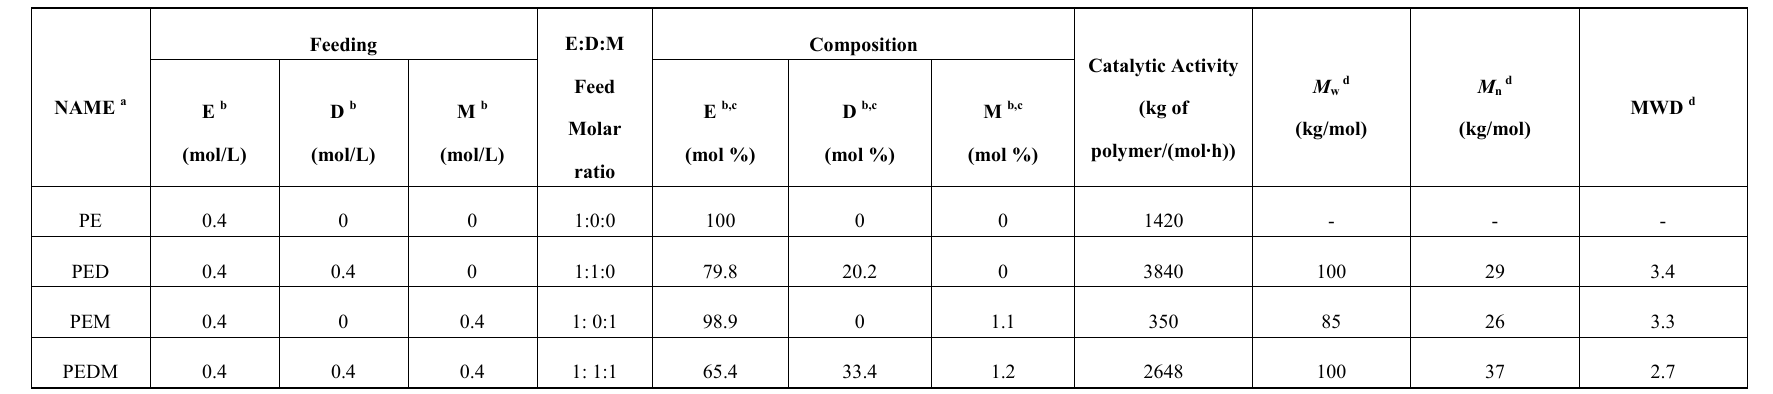
Table 1. Results for homo-, co- and